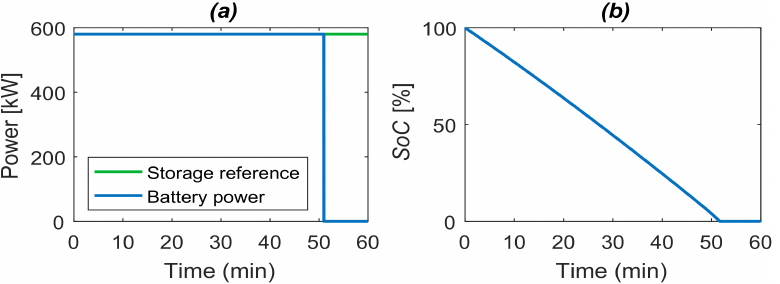
Figure 11. Intensium Max 20M (IM20M) storage system discharge curve, ( a ) power discharge and ( b )